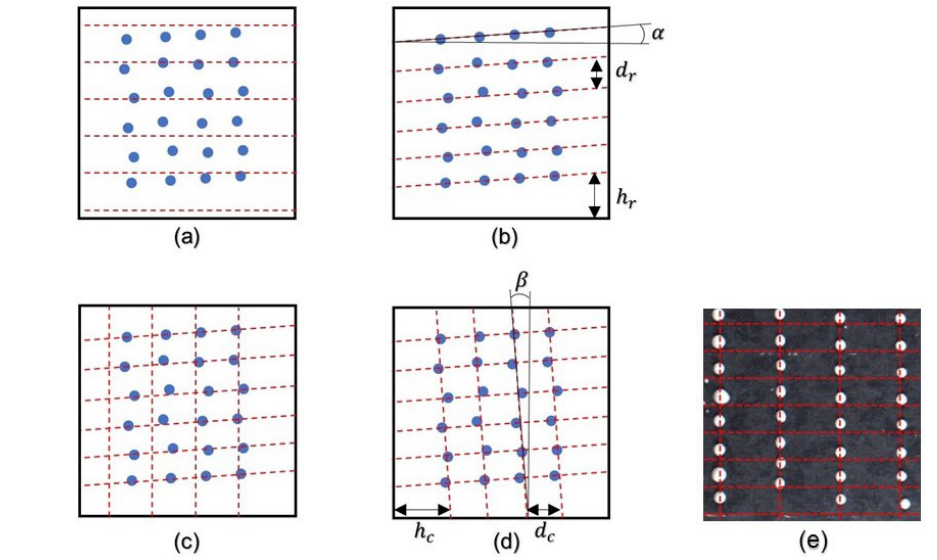
Figure 4. Graphical step-by-step representation of the algorithm used for calculating deviations from grid positions on a set of exemplary points with highly exaggerated deviations from a regular grid including an overall skew. (a) A set of horizontal lines is placed over the centroid positions of the printed dots. Line distance is in accordance with the line distance of the printed pattern. (b) The starting height h r of the first row, the absolute distance d r between rows, and the angle α are then optimized. (c) As the next step, a set of vertical, evenly spaced lines is added. The starting height h c of the first column, the column distance d c , and column angle β are optimized analogous to the first set of lines as seen in (d) . The grid positions (on which dots are expected to appear) are defined as the cross points of the two sets of lines. In (e) the result of a real computation of the described algorithm on a printed image is shown. The different characteristic errors from Fig. 1 are observable and now quantifiable.